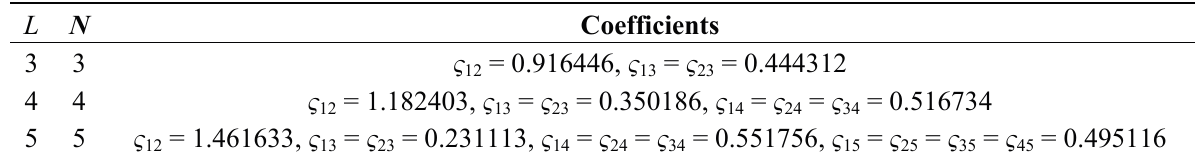
Table 8. Coefficients expanded from the LMShc coefficients in Table 4.